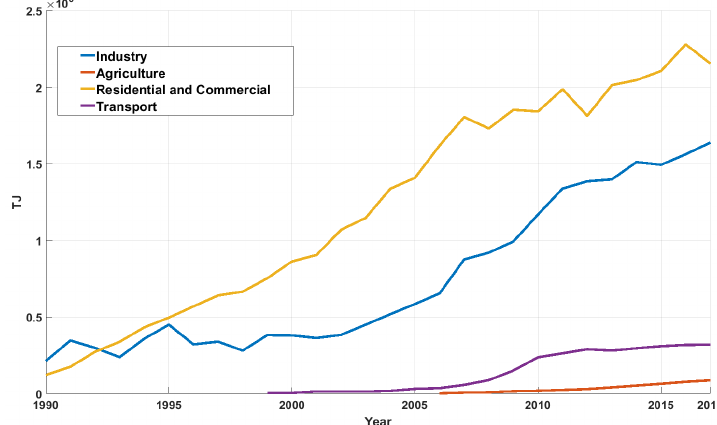
Figure 6. Natural gas consumption in Iran by